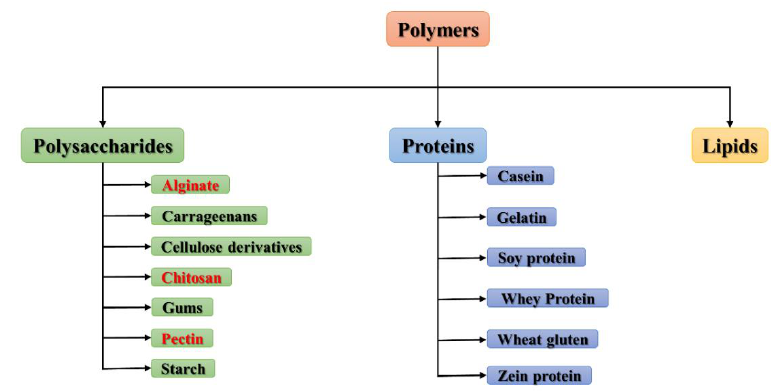
Figure 1. Classification of polymers from the nutritional point of view as carbohydrates, proteins, and lipids.